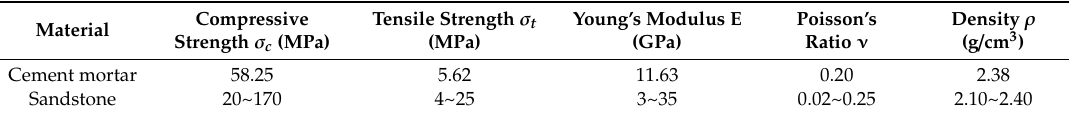
Table 1. Physico-mechanical parameters of cement mortar and